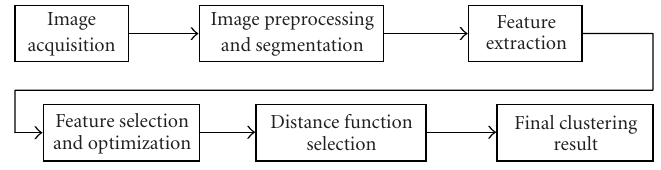
Figure 1. Flow chart for clustering protein subcellular location